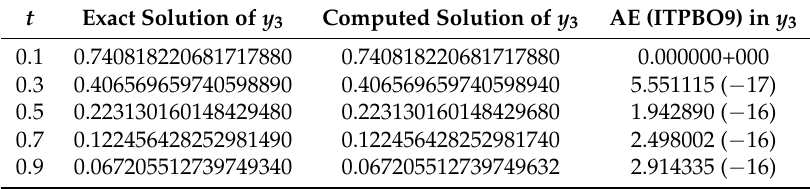
Table 8. Numerical findings for solving y 3 of Problem 4, h = 0.01, t ∈ [ 0,1 ]